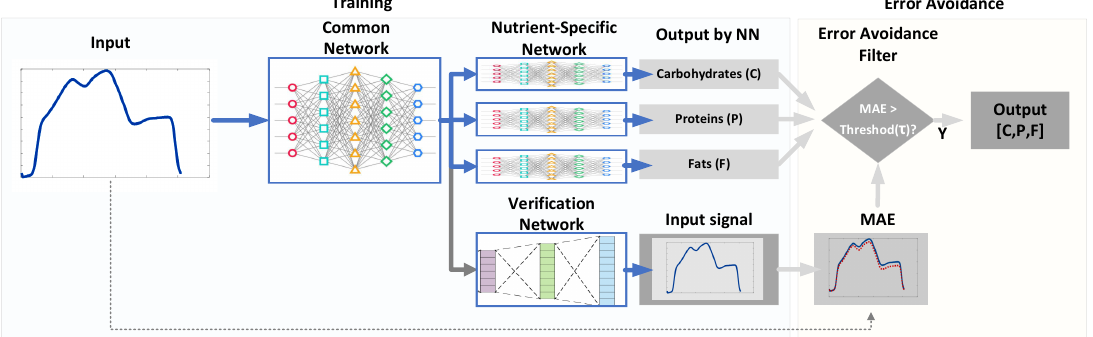
Figure 1. The proposed system for estimating the composition of food nutrients from the measurements of hyperspectral